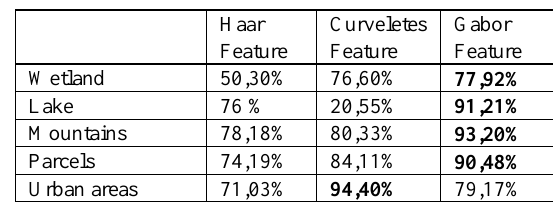
Figure 7. Normalized error over source separation approaches The proposed source separation process enhances data